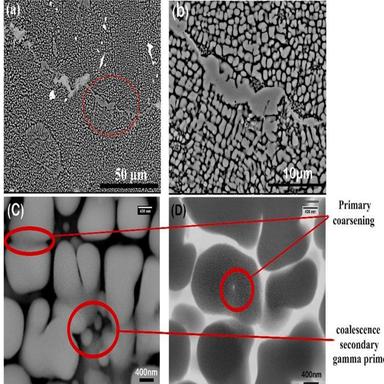
The primary γ́ phase coarsening and disappearing secondary γ́ (TE zone of 75,000 h exposed blade).